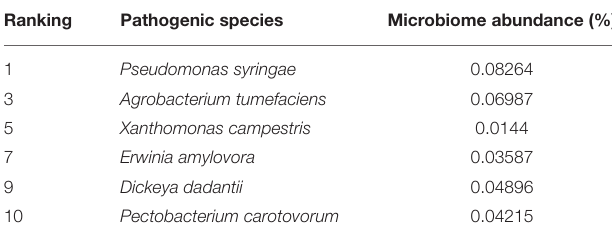
TABLE 2 | A selection of the most abundant phylogenetic groups present in the gut microbial community down to genus level. Classification